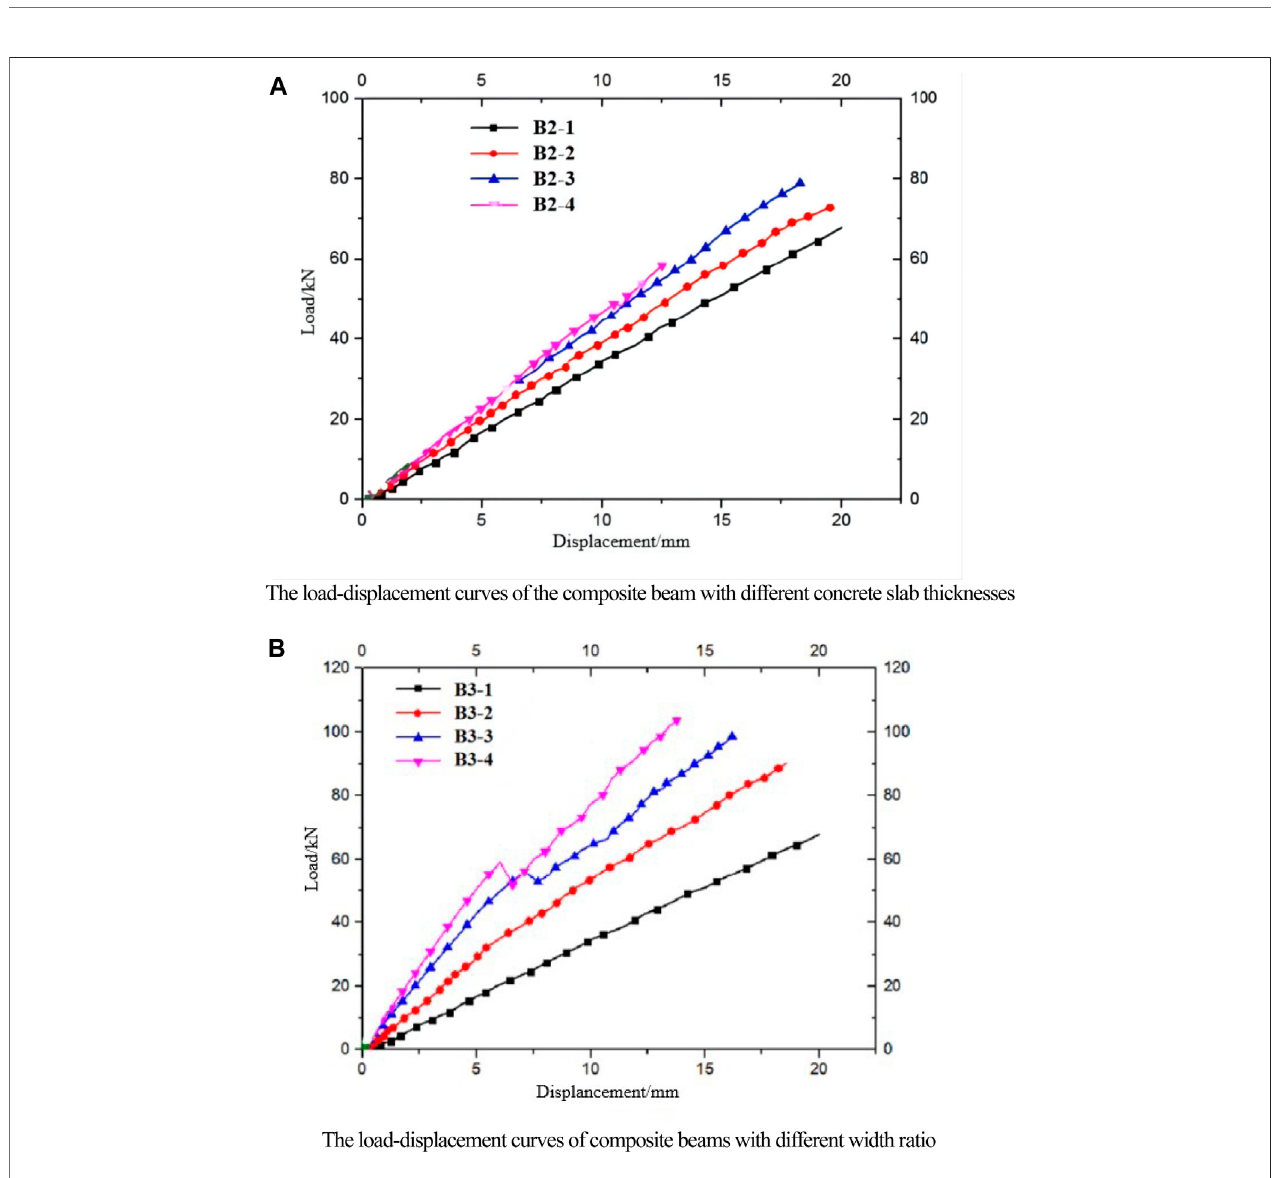
FIGURE 9 | Effects of the width ratio and thicknesses of the concrete slab on the load performance of the composite beam. (A) Load – displacement curves of the composite beam with different concrete slab thicknesses. (B) Load – displacement curves of composite beams with different width ratios.